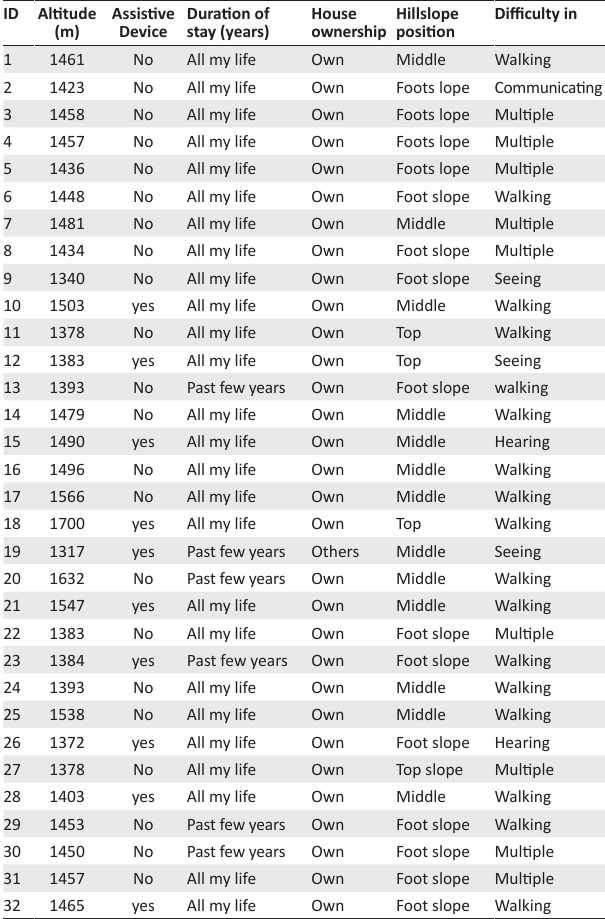
TABLE 3: Respondents’